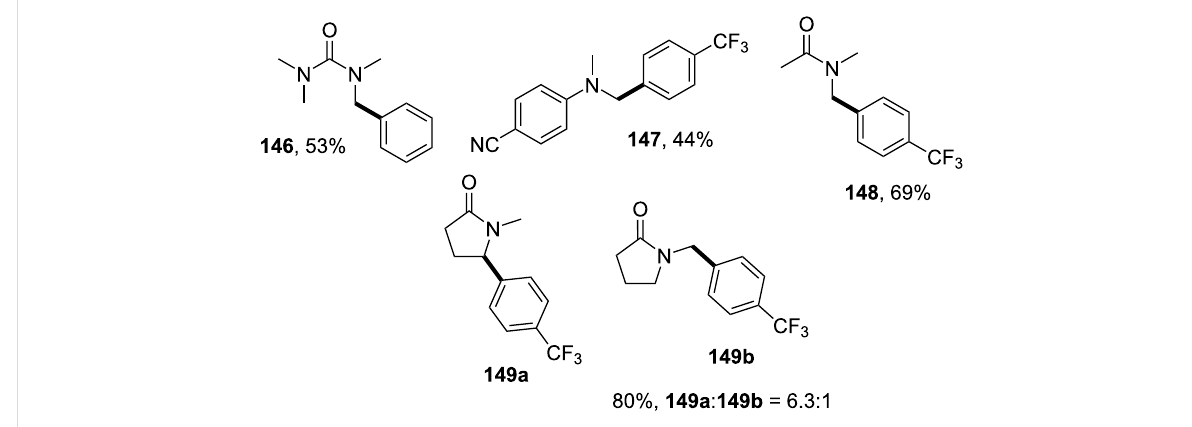
Scheme 33: Additional products yielded by the photochemical alkylation reaction of N-containing molecules.